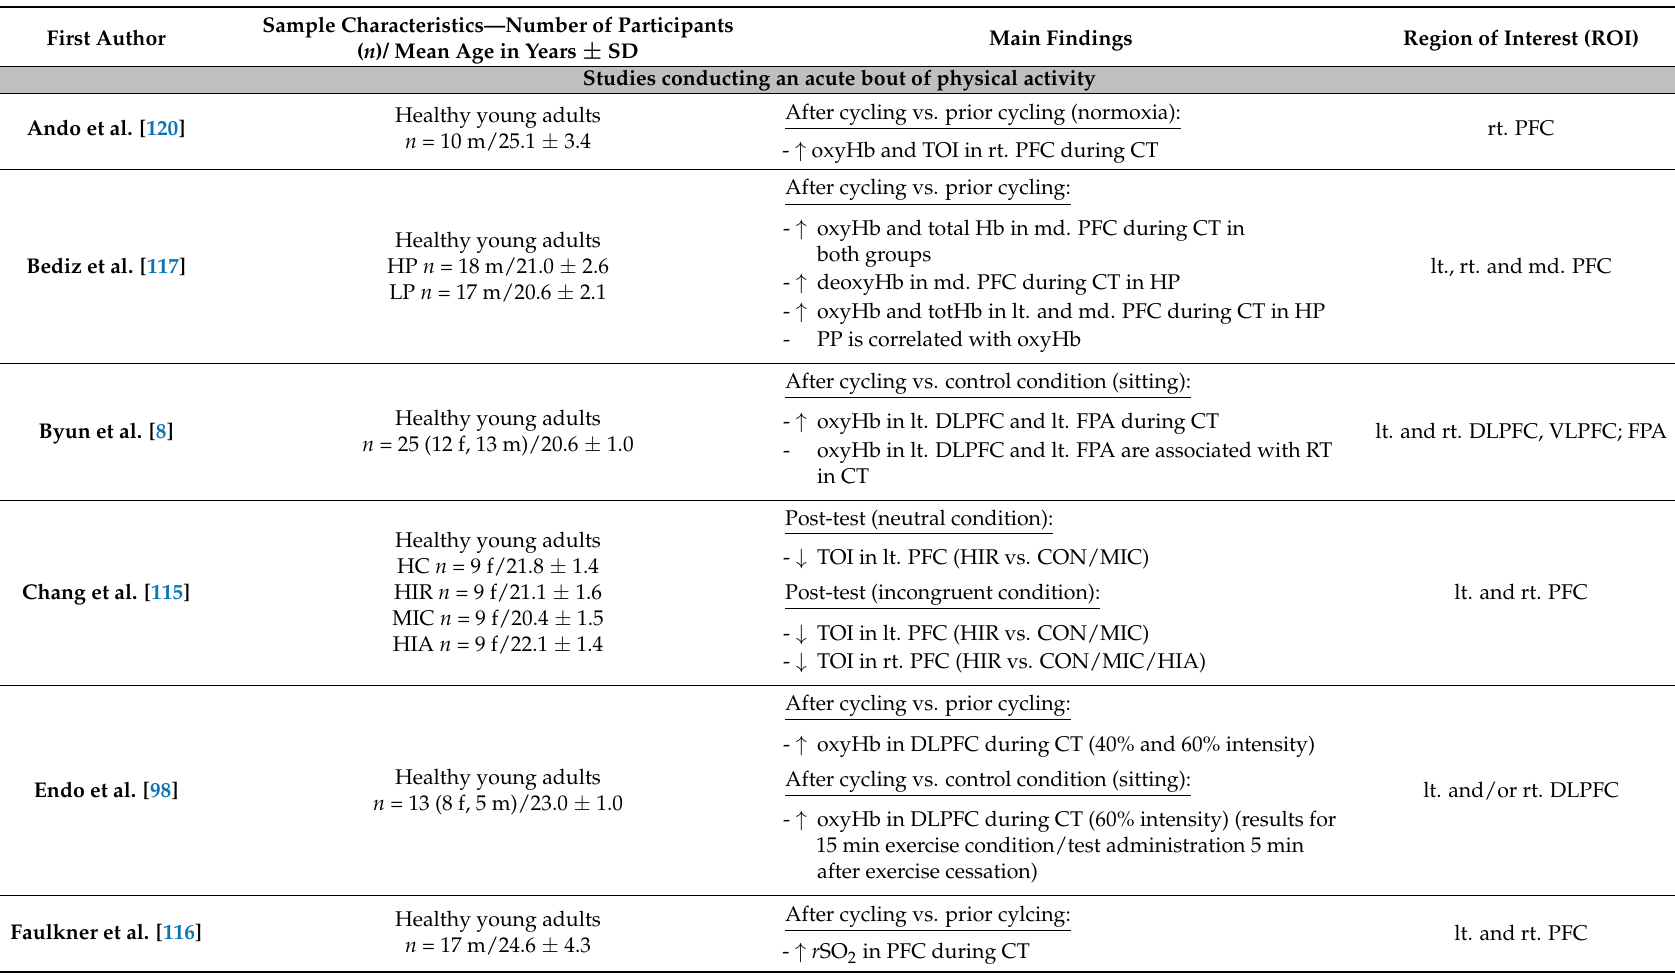
Table 1. Overview about the population characteristics, fNIRS methodology and data processing, exercise characteristics and cognitive testing, and main outcomes of reviewed